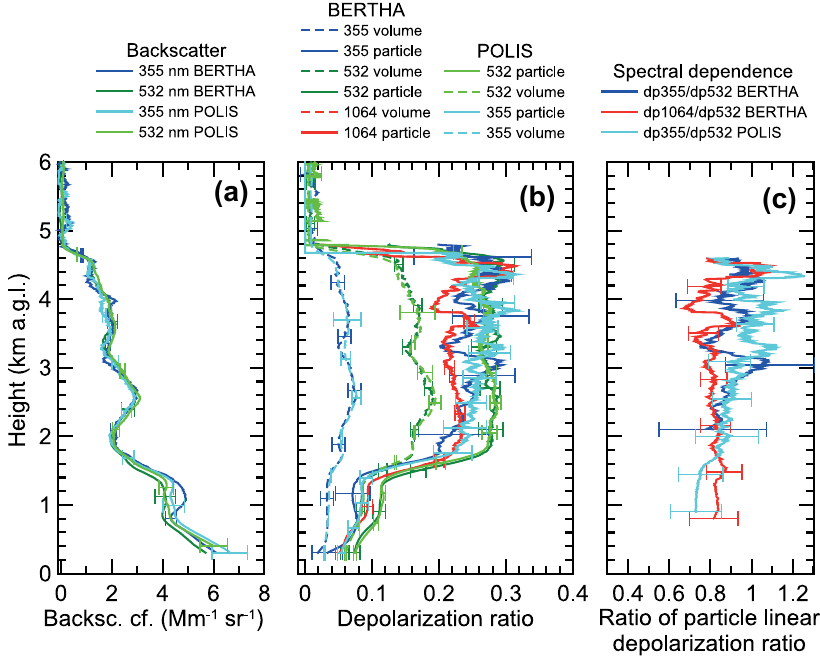
Figure 5. Comparison of POLIS and BERTHA depolarization-ratio observations. Shown are 45min mean profiles of (a) the particle backscat- ter coefficient at 355 (POLIS light blue, BERTHA dark blue) and 532nm wavelength (POLIS light green, BERTHA dark green); (b) the volume (dashed curves) and particle linear depolarization ratio (solid lines) at 355nm (POLIS light blue, BERTHA dark blue), 532nm (PO- LIS light green, BERTHA dark green), and 1064nm (BERTHA, red line, equal volume and particle depolarization-ratio profiles); and (c) the ratio of the 355 to 532nm particle depolarization ratio (POLIS light blue, BERTHA dark blue) and 1064 to 532nm particle depolarization ratio (BERTHA, red). POLIS and BERTHA observations were taken simultaneously on 11 July 2013, 00:00–00:45UTC. Error bars indicate the retrieval uncertainty (1 standard deviation). The vertical signal smoothing window length is 200m (BERTHA, POLIS).